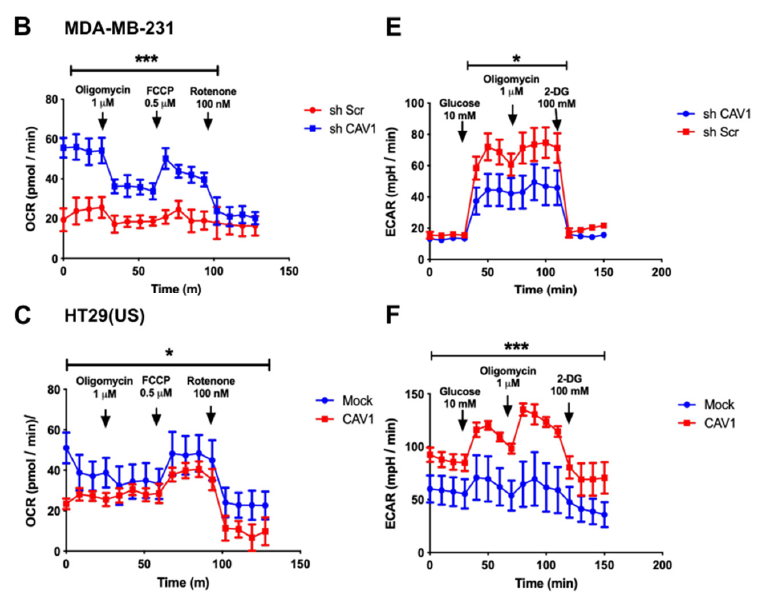
Figure 1. Caveolin-1 expression decreased oxygen consumption and increased the glycolysis rate in metastatic cancer cell lines. ( A ) B16F10 cells (2 × 10 5 ), ( B ) MDA-MB-231cells (4 × 10 5 ), or ( C ) HT29(US) cells (1 × 10 5 ) that express (CAV1 or shScr, red line) or not CAV1 (Mock or shCAV1, blue line) were seeded in a 24-well plate, and 24 h later the oxygen consumption rate (OCR) was measured. To this end, cells were incubated for 1 h with 1 mL per well of Seahorse Bioscience XF24 Calibrant pH 7.4 media supplemented with 100 mM Pyruvate and 5.5 mM glucose at 37 ◦ C. Cells were treated with 1 µ M Oligomycin, 0.5 µ M Carbonyl cyanide- p -trifluoromethoxyphenylhydrazone (FCCP), and finally 100 nM Rotenone. The oxygen consumption rate was evaluated by measuring the changes in the emission of the oxygen fluorophore embedded in the Seahorse sensor plate, using a XF24 Seahorse extracellular flow analyzer. ( D ) B16F10 cells (2 × 10 5 ), ( E ) MDA-MB-231 cells (4 × 10 5 ), or ( F ) HT29(US) cells (1 × 10 5 ) that express (CAV1 or shScr, red line) or not CAV1 (Mock or shCAV1, blue line) were seeded in a 24-well plate, and 24 h later the glycolysis rate was measured by the determination of the extracellular acidification rate (ECAR). Here, cells were incubated for 1 h with 1 mL per well of DMEM media, pH 7.35, supplemented with 143 mM NaCl, 2 mM L-glutamine, and 100 mM 2-Deoxy-D-glucose (2-DG). The extracellular acidification rate was evaluated by measuring the changes in the emission of the proton fluorophore embedded in the Seahorse sensor plate, using a XF24 Seahorse extracellular flow analyzer. The graphs show the averages of results from three independent experiments (mean ± SEM). Significant differences in comparison to the Mock or shCAV1 condition are indicated * p < 0.05, *** p ≤